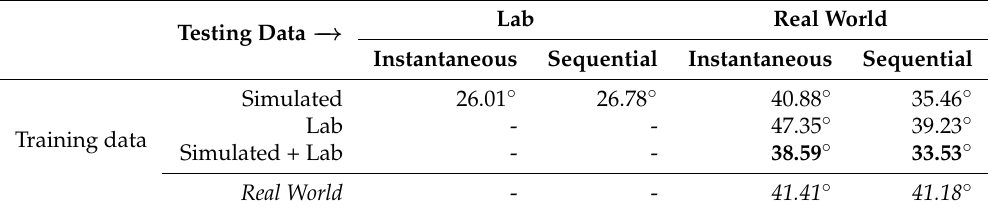
Table 1. Mean absolute error of the body angle estimate for different training and testing datasets.